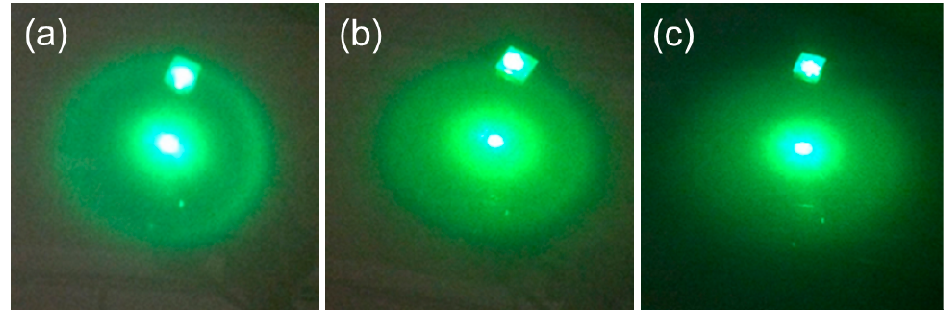
Figure 9. Diffraction patterns of a green laser beam traveling through the SPMs array on glass slides ( a ) below; ( b ) close to; and ( c ) above the LCST.